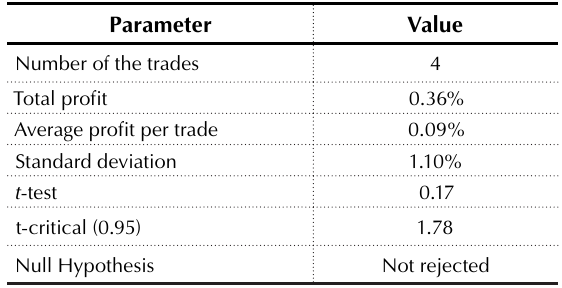
Table 13. T -test for evaluating the success of the trading strategy: PFST returns over the period 1991–2018, natural disasters,